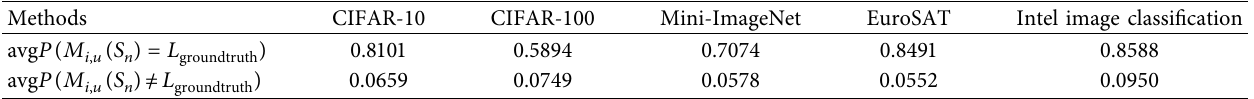
Figure 7: The probability of labels by different models of corresponding domain. (a) The ground truth is label 1 of domain 0. (b) The ground truth is label 9 of domain 1. (c) The ground truth is label 90 of domain 2. Table 8: Statistical analysis of predicting